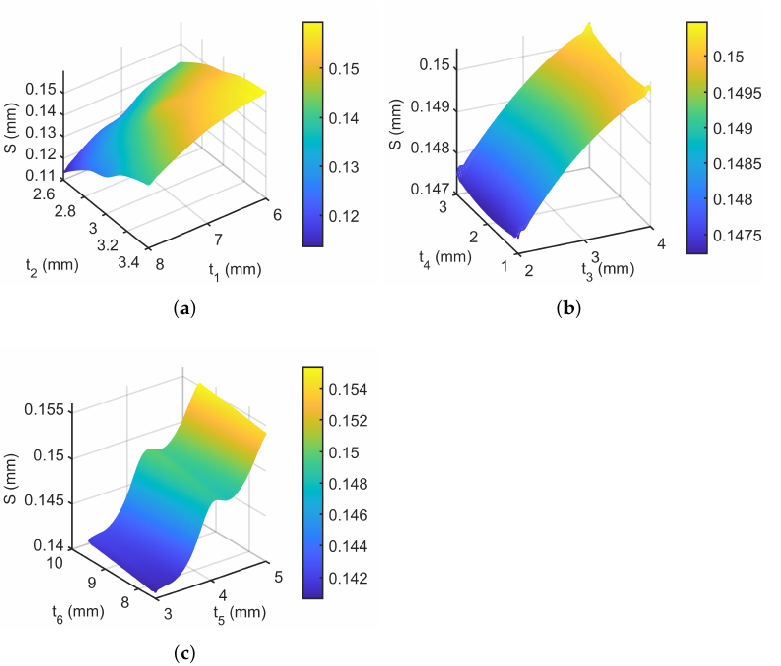
Figure 4. Thecontribution of design variables on the maximum output displacement based on sensitivity analysis.